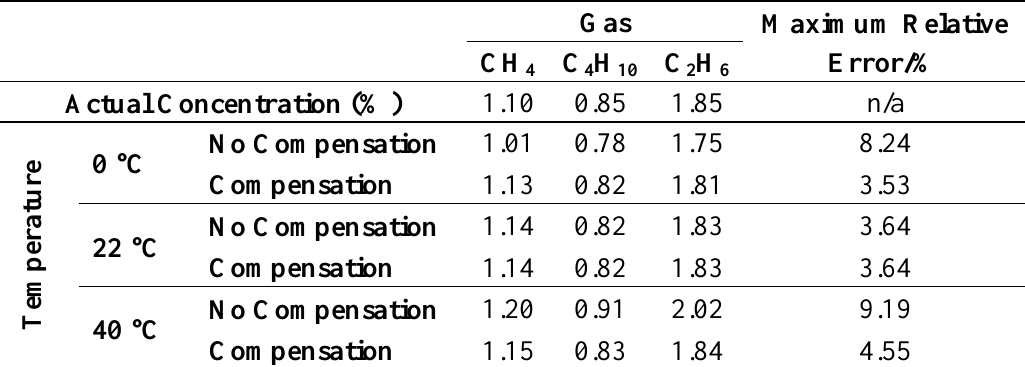
Table 2. Analysis result of combustible mixtures under different